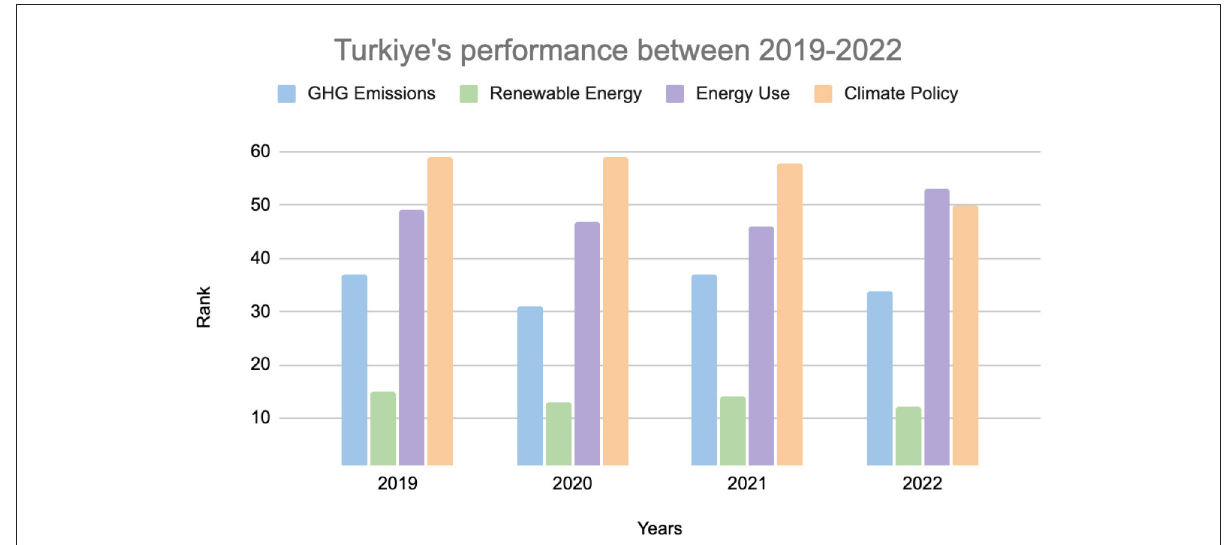
FIGURE1 Ranking of Turkiye according to all categories in CCPI reports between 2019 and 2022 [Source: Burck et al. (2019, 2020, 2021, 2022a)].